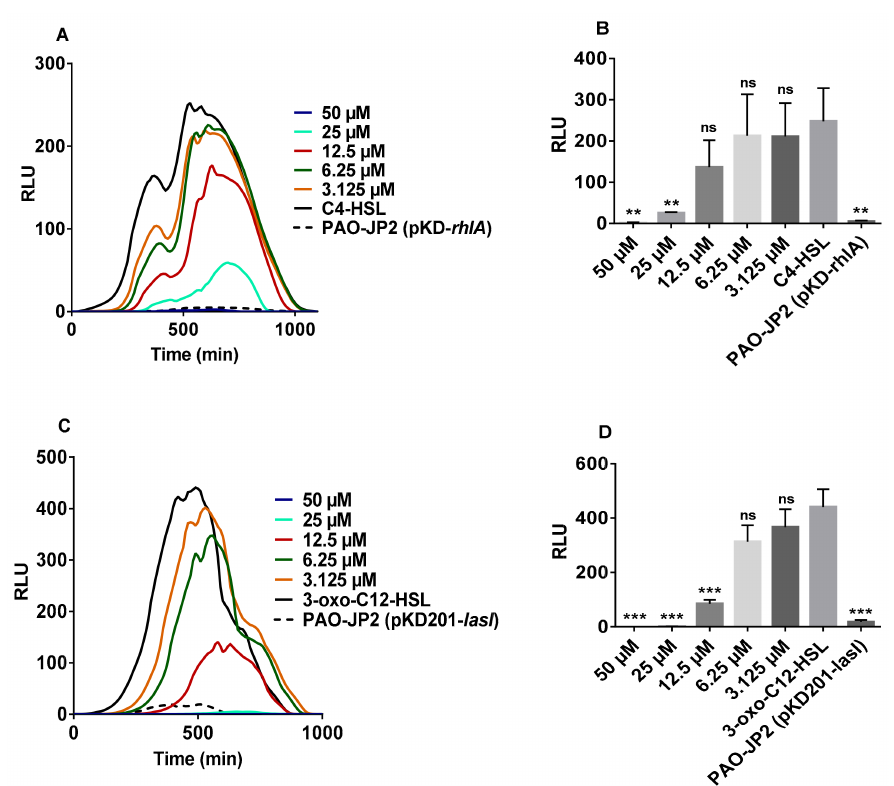
Figure 1. Inhibitory actions of furanone C-30 on RhlR and LasR. ( A ) Impact of furanone C-30 on RhlR. ( B ) RhlR inhibition relative to the control, correlating to the data in panel A. ( C ) Impact of furanone C-30 on LasR. ( D ) LasR inhibition relative to the control, corresponding to the data in panel C. The final concentration of 3-oxo-C12-HSL and C4-SHL were 100 nM and 10 µ M, respectively. All concentrations presented are the final concentrations. Luminescence was expressed as relative luminescence units or RLU. ** p < 0.01, *** p < 0.001, and ns not significant. Values represent mean ± SD, n = 3 (three experimental